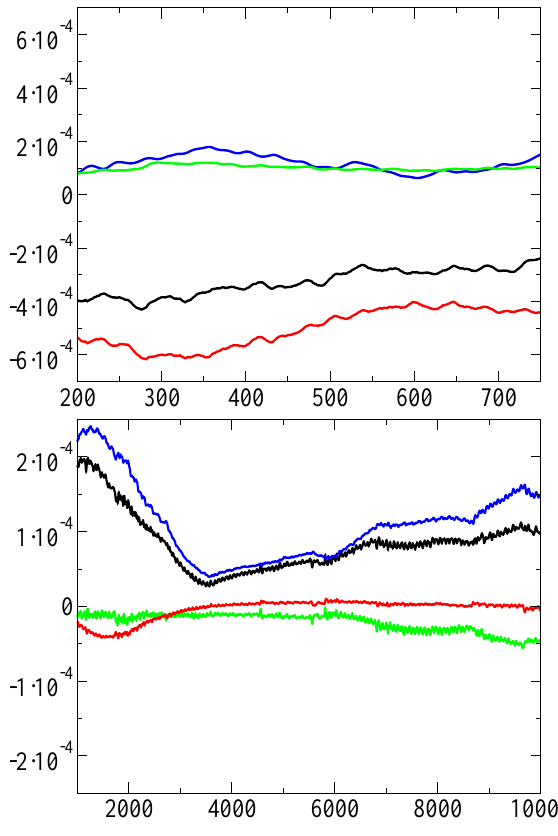
Fig. 6. Time evolution of the terms entering the r.h.s. of the equa- tion for µ k , for two runs of Fig. 3, with d i /l f = 0 . 080 and β = 2 . 4 (top) and β = 0 . 1 (bottom). Same color code as in Fig. 5, i.e., black: total r.h.s.; blue: gyrotropic heat fluxes; green: Hall effect; red: non- gyrotropic pressure.